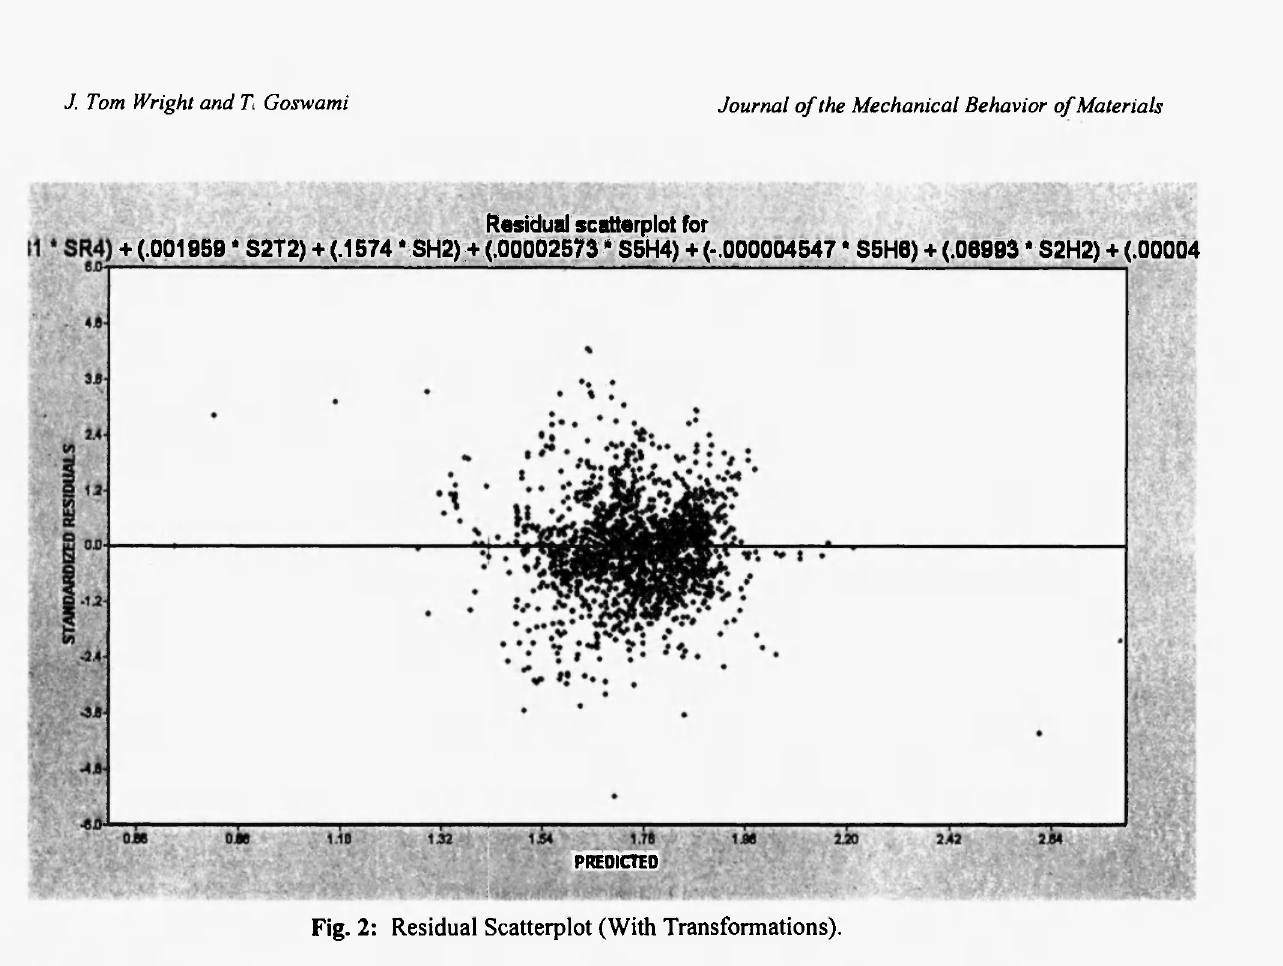
Fig. 2: Residual Scatterplot (With Transformations).